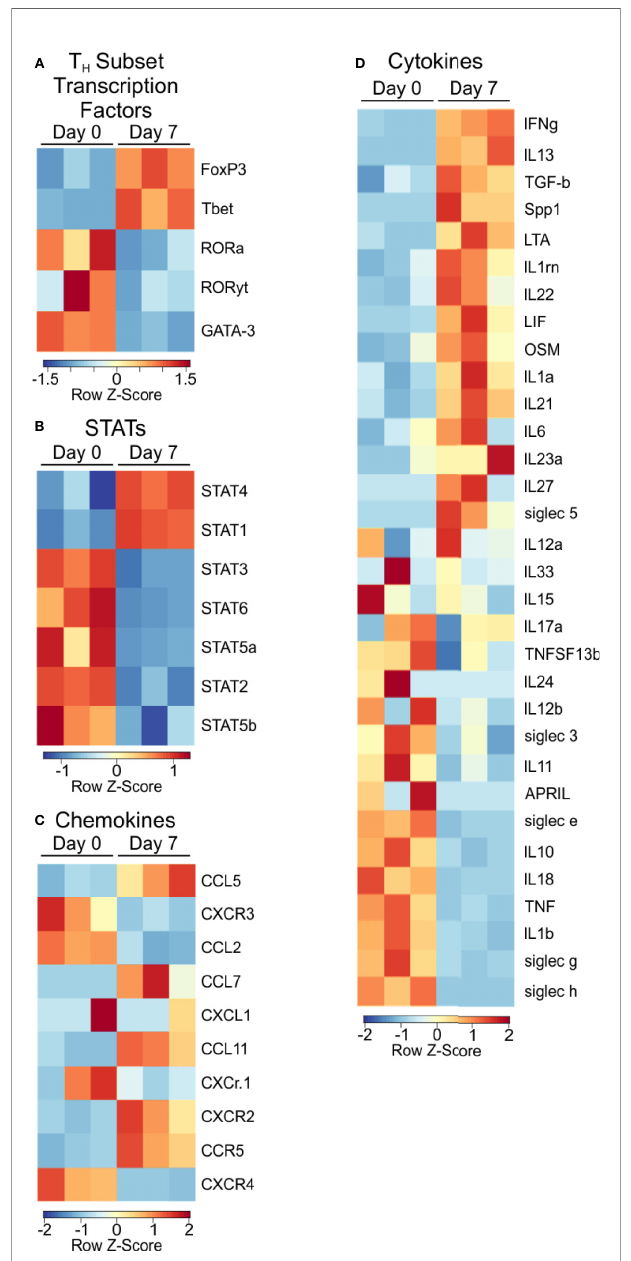
FIGURE 3 | Transcription factor and signaling molecule pro fi le of PSA exposed cells. Heat map of (A) T subtype associated transcription factors, (B) STAT transcription factors, (C) Chemokines, and (D) Cytokines of PSA exposed T cells compared to